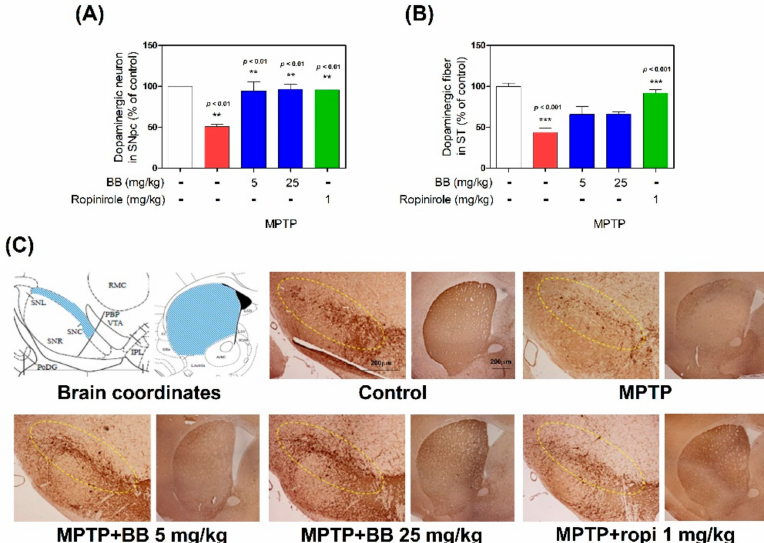
Figure 3. E ff ects of BB on MPTP-induced dopaminergic neuronal damage. Dopaminergic neurons were visualized by tyrosine hydroxylase (TH)-specific Immunohistochemistry (IHC). The TH-positive neurons in the substantia nigra pars compacta (SNpc) were counted ( A ) and the optical density in the striatum (ST) was measured ( B ). Representative photomicrographs were taken of the SNpc and ST ( C ). Values are presented as means ± S.E.M. ** p < 0.01 and *** p < 0.001 compared with the control group. Scale bar: 200 µ m.